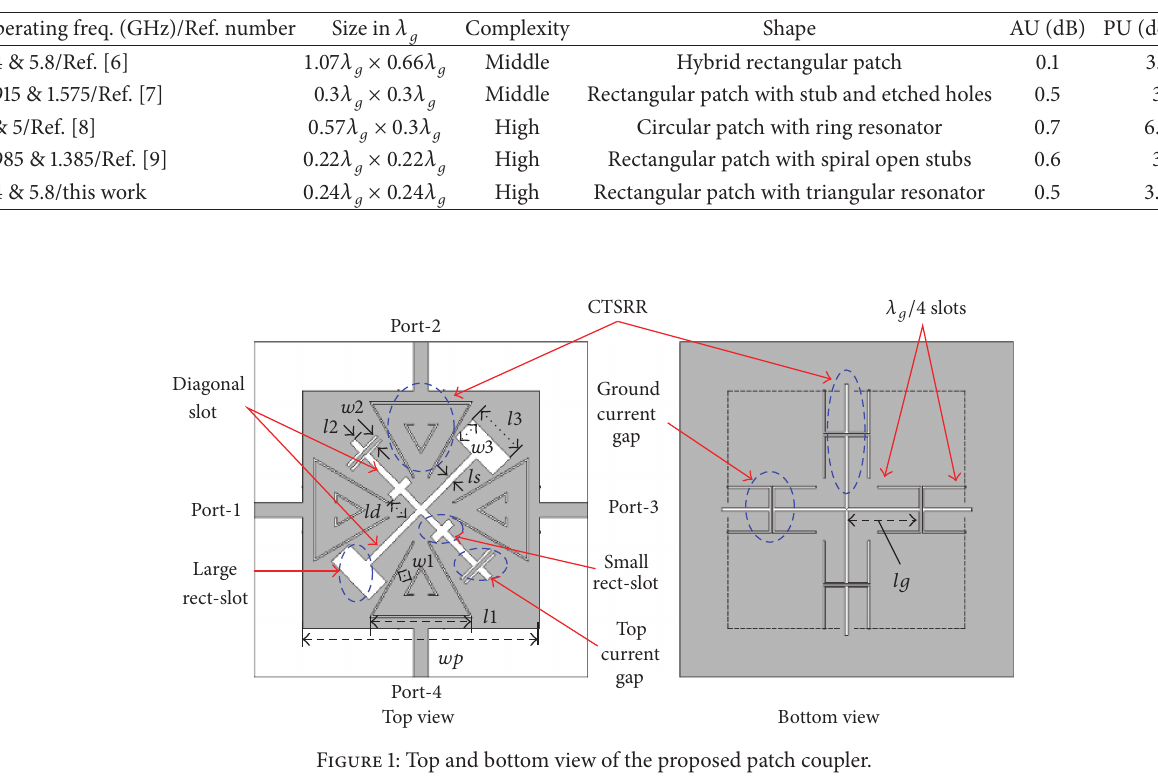
Table 1: Performances of different dual-band patch coupler.